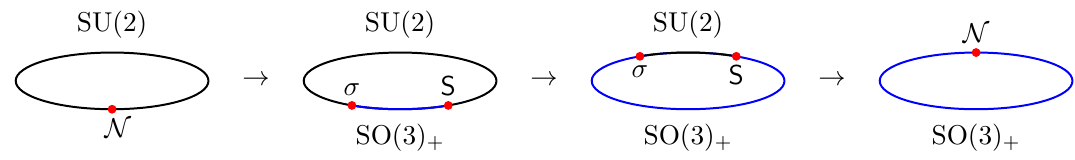
Figure 2 . Left: an insertion of N 2 at a point on S 1 and wrapping M d . Right: after having used the fusion rules, we may replace this with an insertion of the condensate (blue) on all two-cycles of M d . This shows that twisted compactification by the square N 2 of a duality defect is equivalent to normal compactification together with gauging in the remaining three-dimensions (up to charge conjugation).